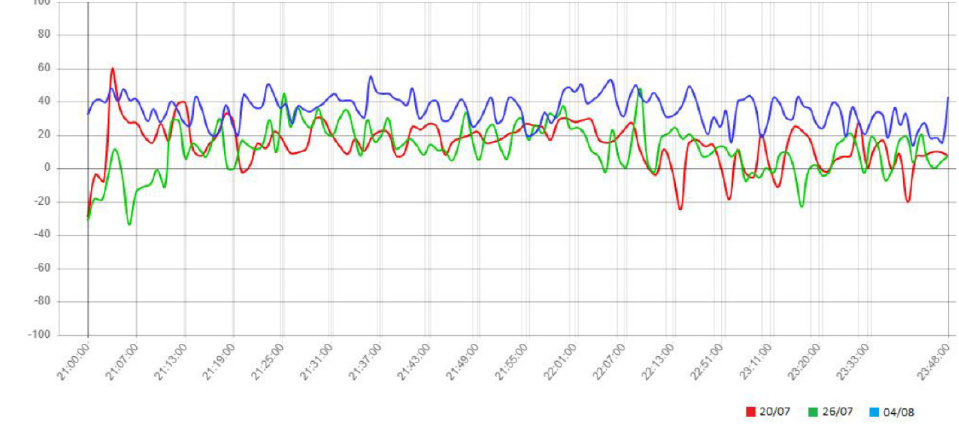
Figure 6. Trend of emotional valence during the three performances of Macbeth.